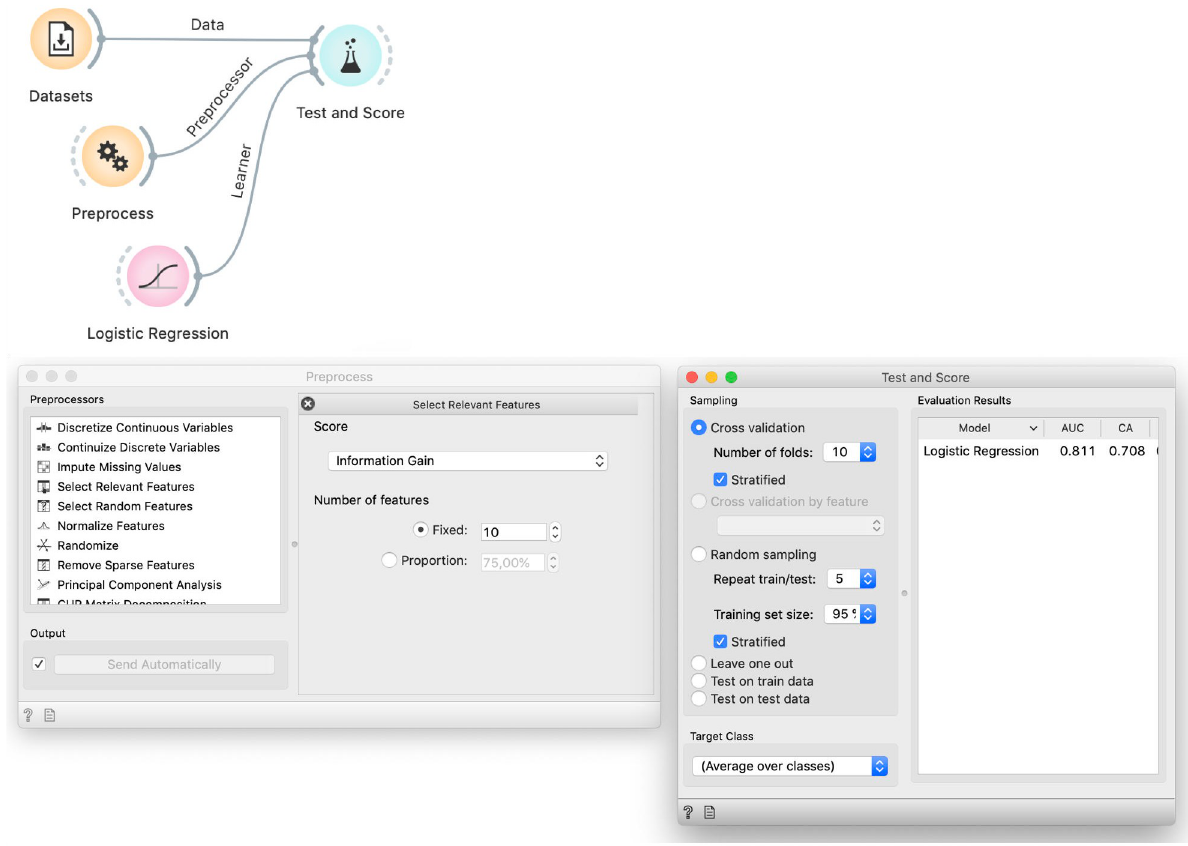
Fig 10. The proper workflow for cross-validation that includes data preprocessing. In this workflow preprocessing is not done prior to splitting the data. The preprocessing recipe, provided by the Preprocess widget, enters the cross-validation procedure and is applied to each training data subset separately, without being informed by the data that is used in